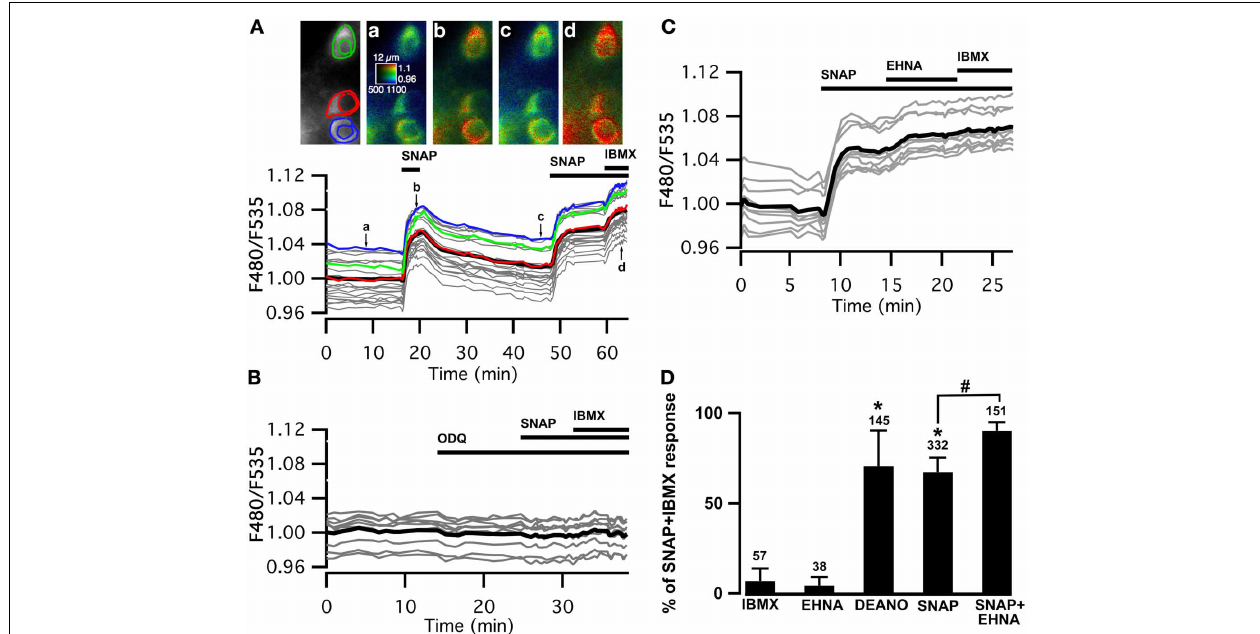
FIGURE 1 | Cygnet reports increases in cyclic GMP concentration in all medium spiny neurons of the striatum in response to soluble guanylyl cyclase activation. (A–C) Striatal neurons in a mouse brain slice expressing Cygnet2 sensor and imaged by wide-field microscopy. (A) Images show the raw fluorescence at 535nm (left in gray scale) and the ratio (in pseudocolor), indicating the ratiometric change of Cygnet2 reporting the binding of cGMP, at the times indicated by the corresponding arrows on the graph below. Each trace on the graph indicates the F480/F535 emission ratio measurement on regions indicated by the color contour drawn on the raw image; the thick black line represents the average of all the traces. The NO donor SNAP (100 µ M) induced a strong increase in the ratio in all MSNs visible in the field.